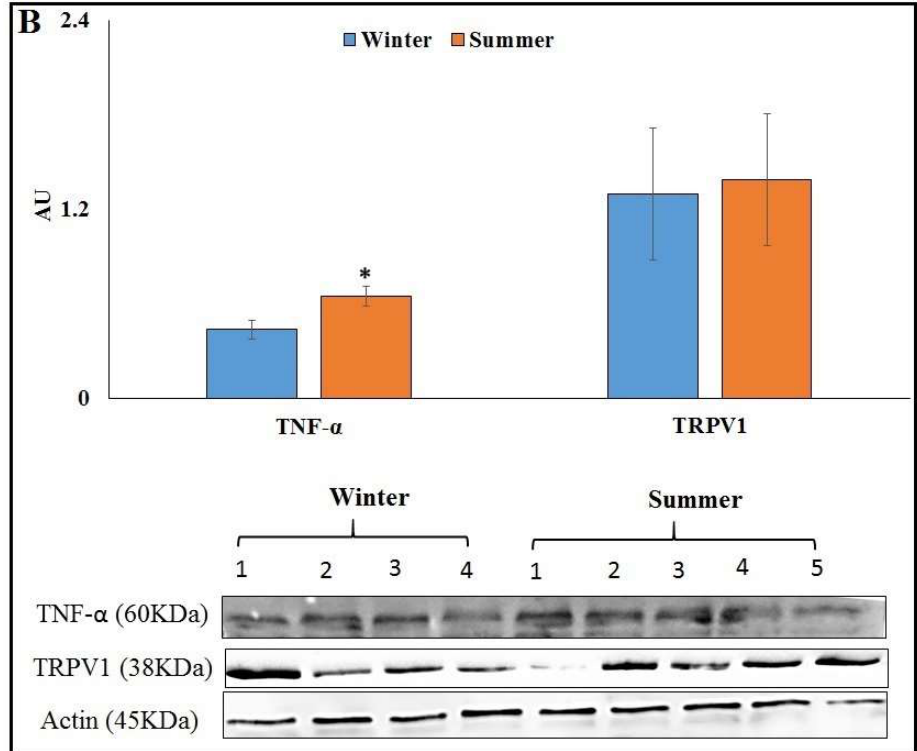
Figure 1. Protein abundance of endocannabinoid system (ECS) components in AT at 7 d PP from cows calving in winter ( n = 9) or summer ( n = 9). ( A ) Presented are the average abundances of CB1, CB2, FAAH, MGLL and PPAR- α , and representative immunoblots of 5 S and 4 W AT. ( B ) Presented are the average abundances of TNF- α and TRPV1, and representative immunoblots of 5 S and 4 W AT. * Significant with p ≤ 0.05.